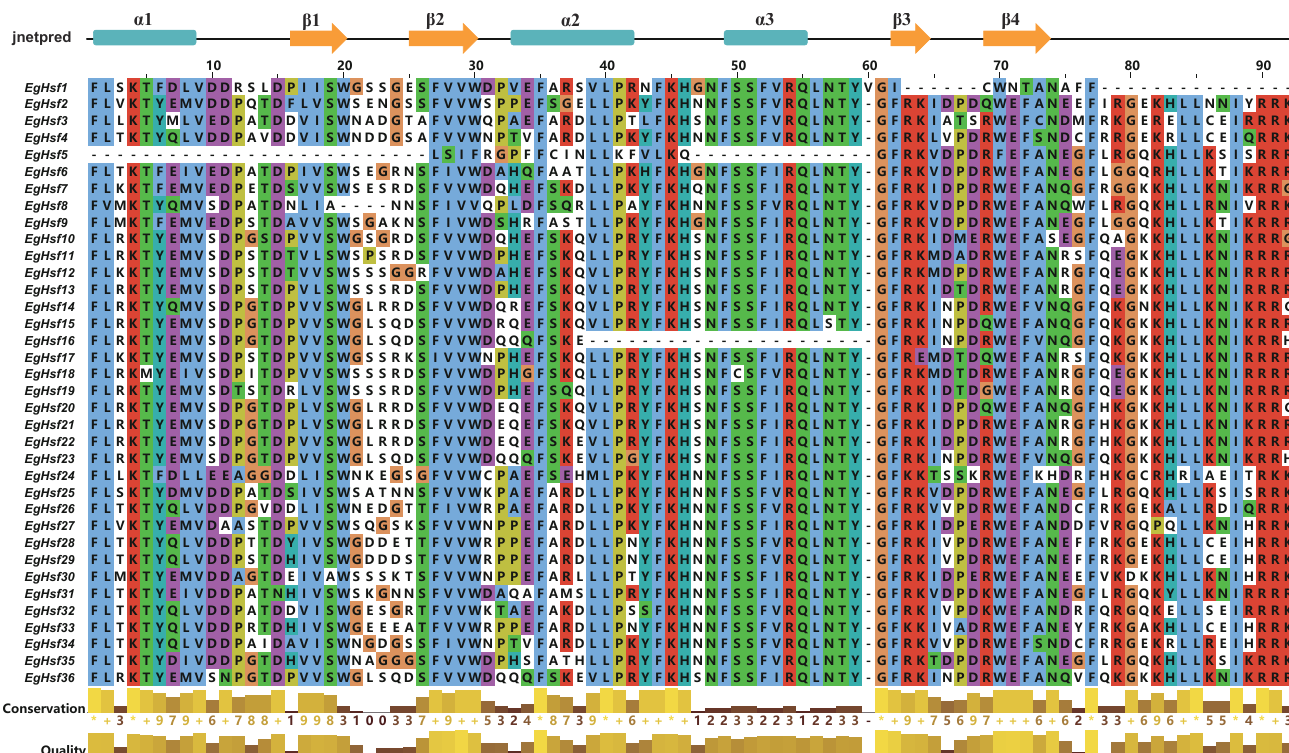
Figure 5. Conversed amino acid sequence in DNA-binding domain of EgHSFs. “*” means that the amino acid residues at this position are absolutely conserved after multiple sequence